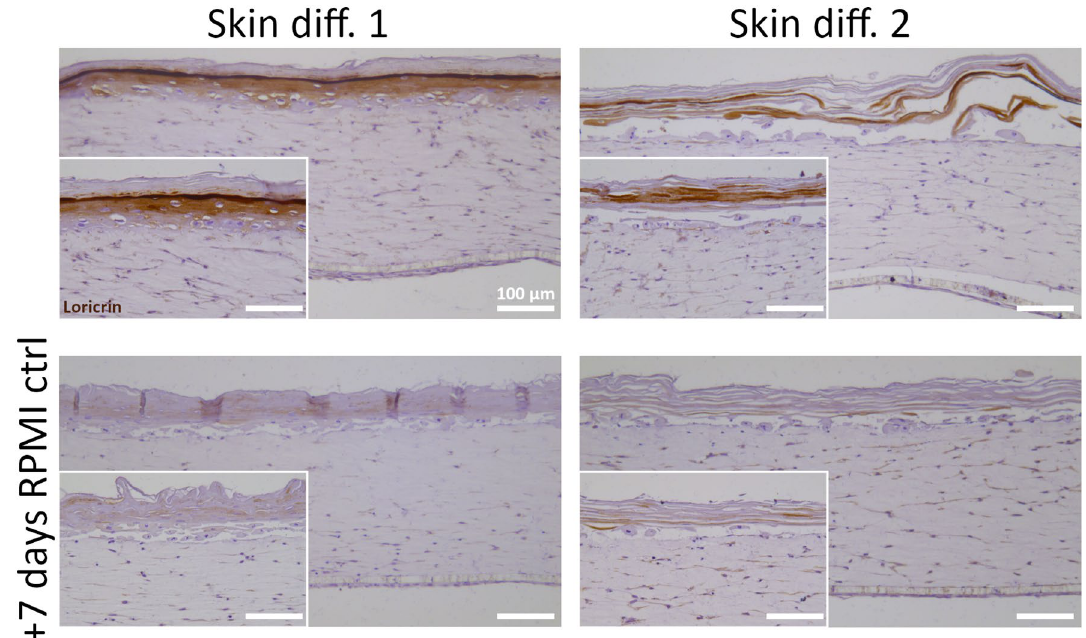
Figure 4. Evaluation of macrophage medium effects on epidermal structure of skin models. In vitro skin equivalents were generated by culture in skin differentiation medium 1 (“Skin diff. 1”) or skin differentiation medium 2 (“Skin diff. 2”) for 14 days at air-lift culture (upper row), and then further cultured for 7 days in RPMI control medium (“RPMI ctrl”) (lower row). Immunohistochemistry against loricrin was performed and counterstaining with hematoxylin followed. N = 2, triplicate measurements. Scale bars: 100